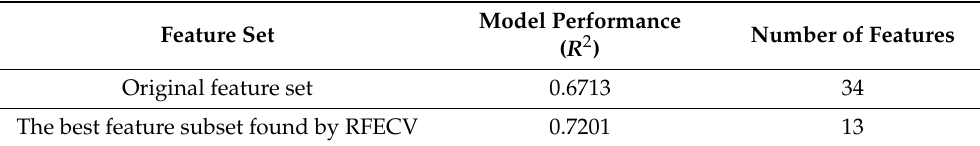
Table 8. Results of feature selection using